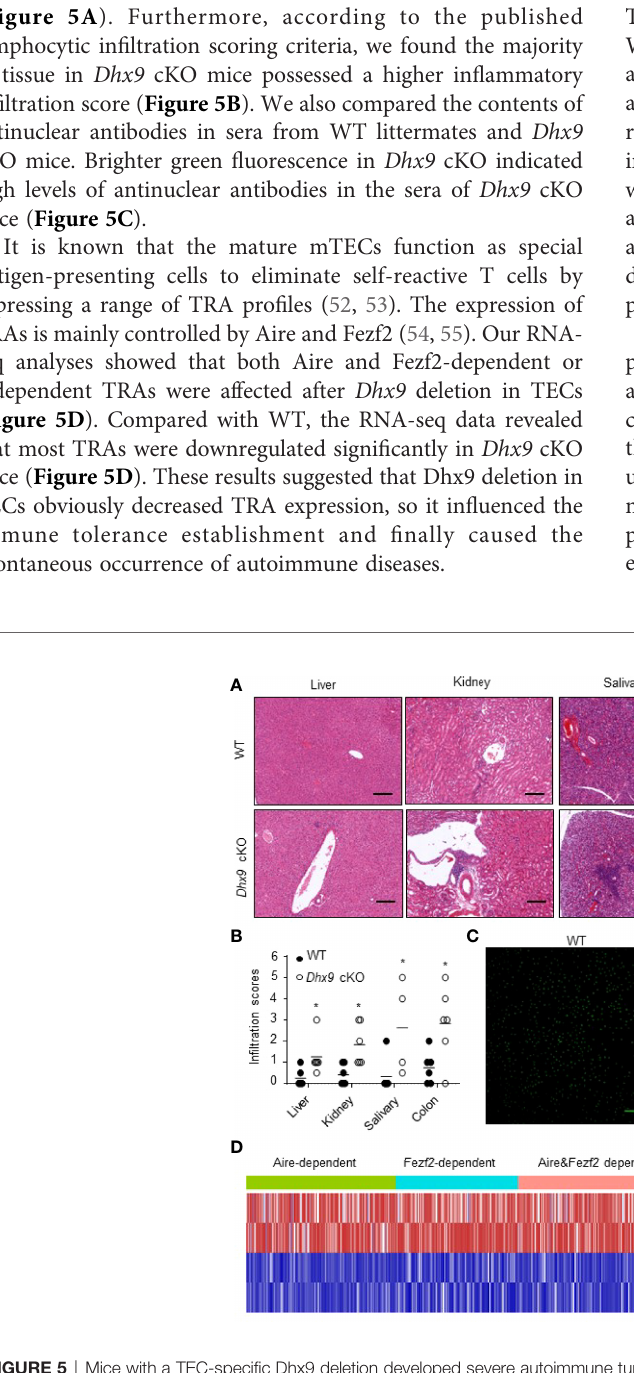
FIGURE 5 | Mice with a TEC-speci fi c Dhx9 deletion developed severe autoimmune turbulence. (A) Representative H&E stained histological sections of the liver, kidney, salivary, and colon from 8-month-old WT and Dhx9 cKO mice, Scale bars: 200 m m. (B) In fi ltration scores and means of H&E staining of WT and Dhx9 cKO mice. One representative histogram represented the mean for n = 6 mice in each group. The unpaired, two-tailed student ’ s t -test was used. * P < 0.05, compared with WT control mice. (C) Antinuclear antibodies in the sera of 8-month-old WT and Dhx9 cKO mice were examined using immuno fl uorescence staining in Hep-2 cell, Scale bars: 200 m m. (D) Heatmap of the downregulated TRA genes ( p < 0.05) in mTEC hi of WT and Dhx9 cKO